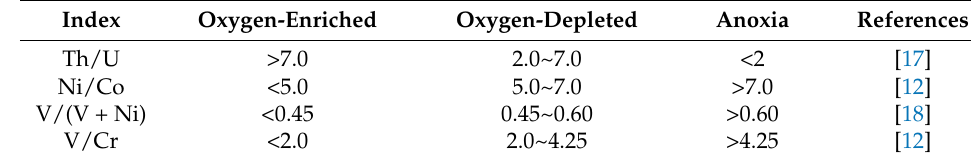
Figure 4. Paleosalinity discrimination of the mudstones in the Meitan Formation. TOC = Total or- ganic carbon.